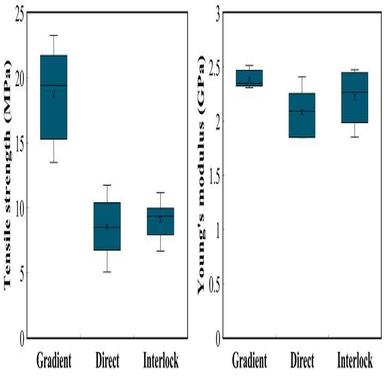
Fractured specimens after tensile testing (a) gradient transition (b) fractured surface of direct transition (c) interlock pattern.